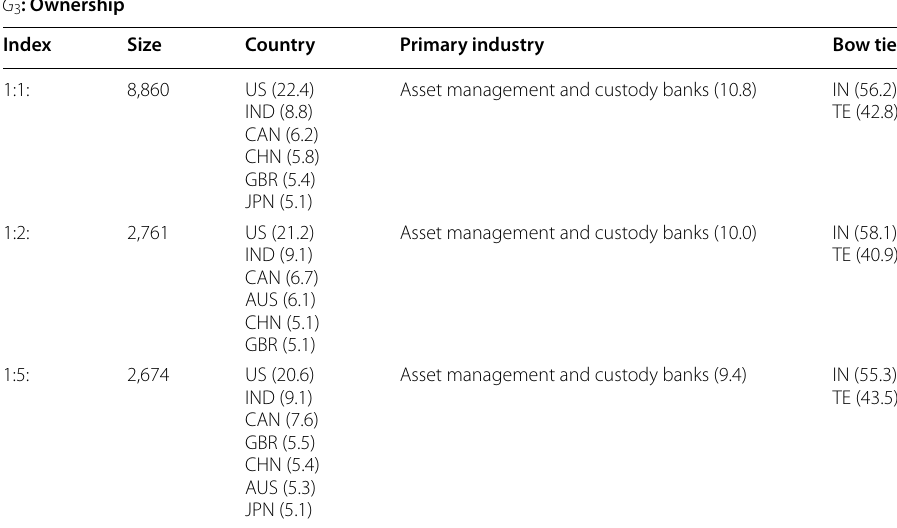
Table 12 Characteristics of the largest community at the first level for the ownership layer and the three largest communities at the second